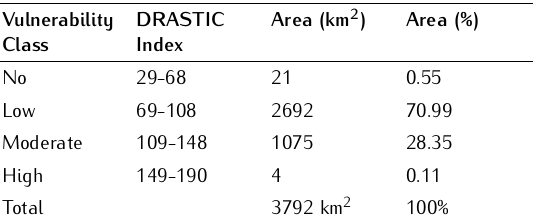
Table 8. Modified risk assessment index MD (i) (using land use) for the study